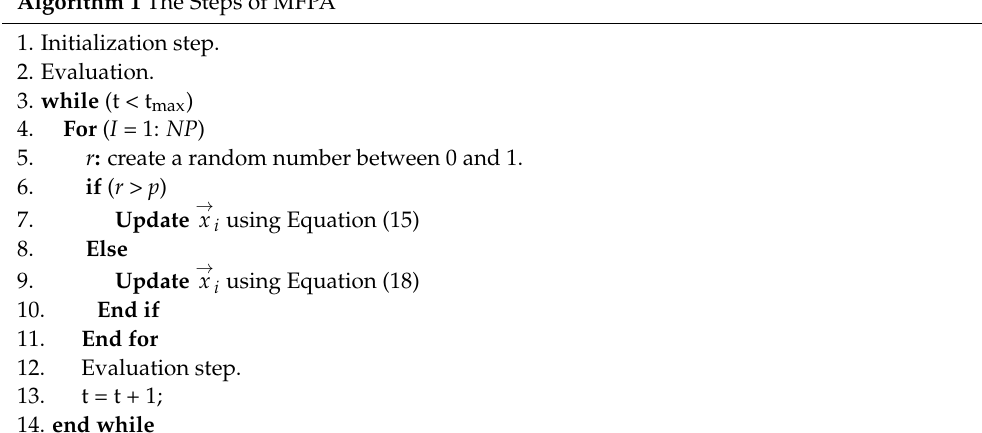
Algorithm 1 The Steps of MFPA